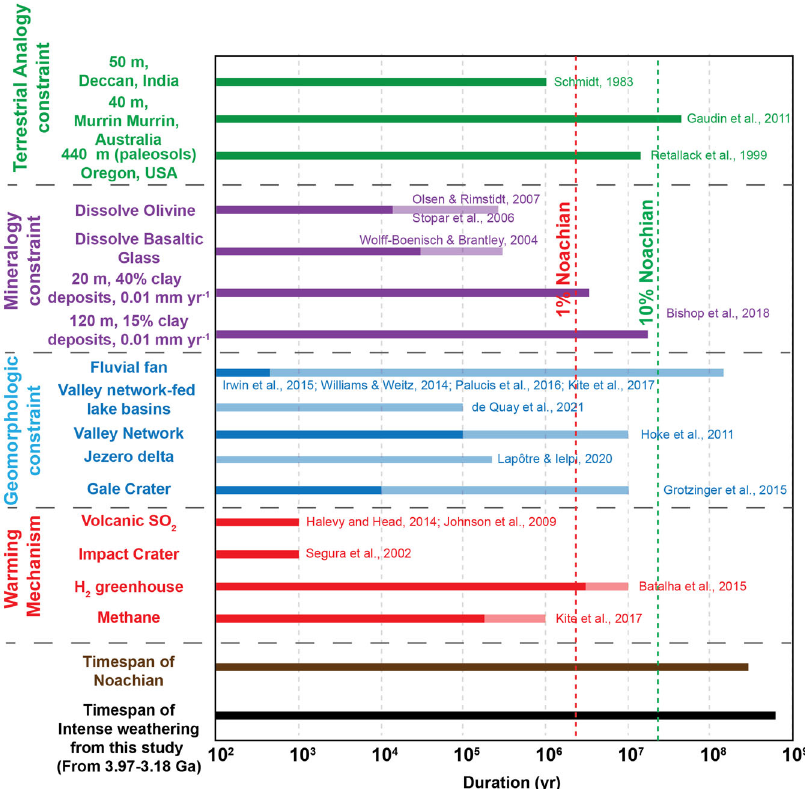
Fig. 8 The timescales of warming mechanisms, geomorphologic constraints, mineralogic constraints, and constraints from terrestrial analogs from the previous studies 3,7,26,50,54,56,59 – 61,68,69,102 . A dark color bar indicates the minimum duration of warming event, geomorphologic constraints and mineralogy constraints, while the light color bar suggests the maximum duration of these constraints. This timeline of Mars process utilizes the Neukum chronology models 93 . Period boundary (green line) is as de fi ned by Werner and Tanaka 91 .